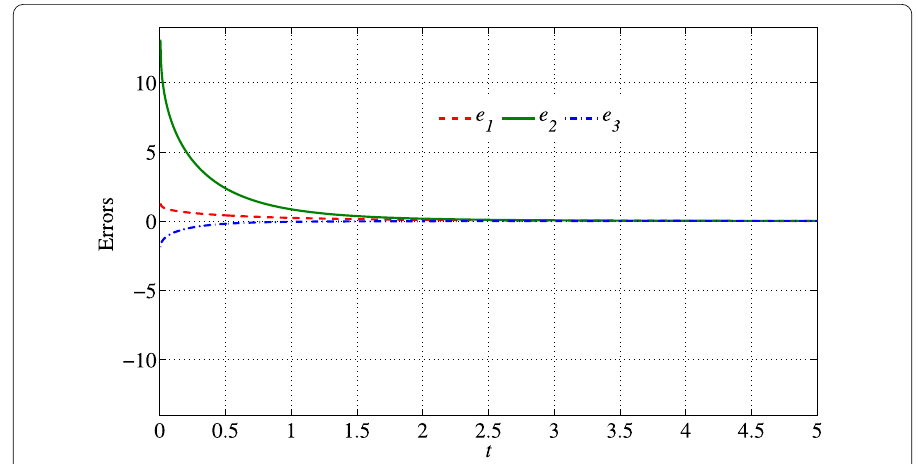
Figure 4 Time series of the synchronized error signals between the master system (12) and the slave system (24) in